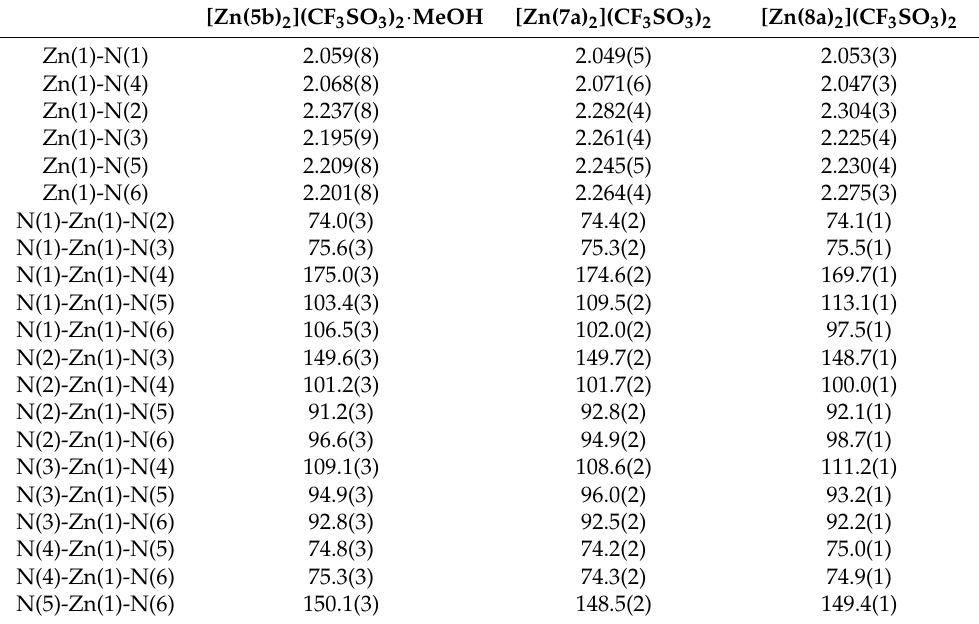
Table 3. Selected geometrical features (bond lengths in Å and bond angles in ◦ ) around the metal center in the three studied